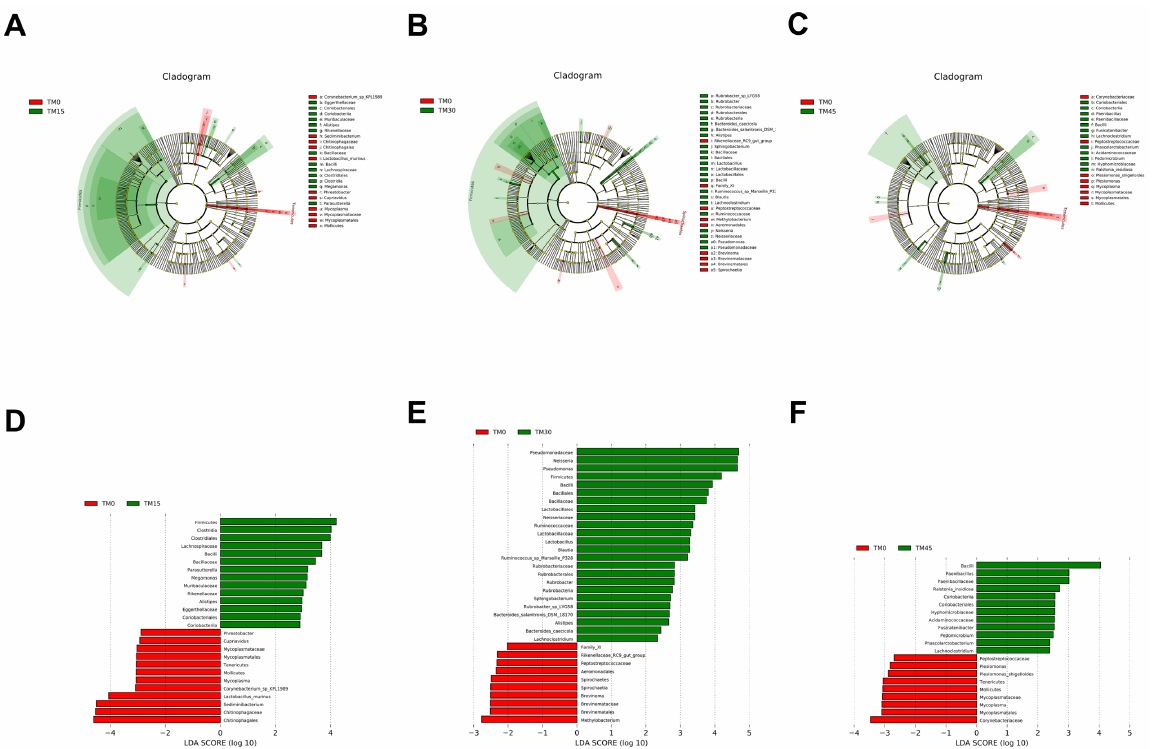
Figure 6. LEFSE (Linear discriminant analysis Effect Size) analysis identified bacterial species that differed significantly in abundance among groups. ( A − C ) Differences in bacterial species abundance were represented by the color (Red indicates a taxon with significantly higher relative abundance in the TM0 group, and green indicates a taxon unit with significantly higher abundance in the TM addition groups). ( D − F ) Linear regression analysis (LDA) was used to estimate the magnitude of the effect of the abundance of each bacterial species on the differential